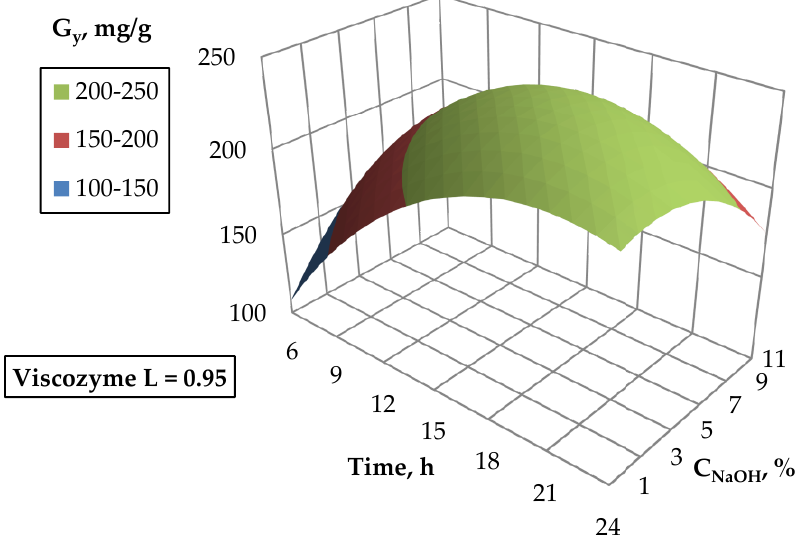
Figure 8. The surface response plots of the effects of NaOH concentration and time on the glucose yield for enzyme ratio of 0.95.